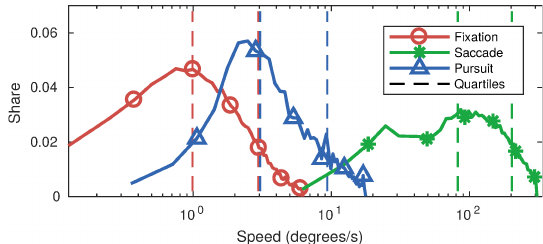
Figure 4. Event speed distribution for the GazeCom data set. Note the logarithmic scale of the x axis (chosen due to the large range of the reported speed for the three classes). The figure presented here is a reproduction of Figure 4 from (Startsev et al.,